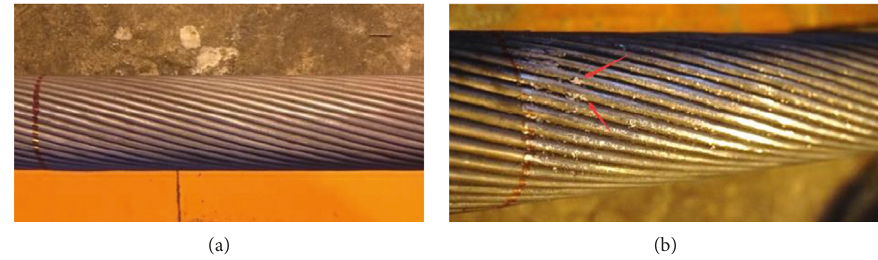
Figure 13: Clamping surfaces of the Galfan-coated cables before and after the test. (a) Before the test; (b) after the test.